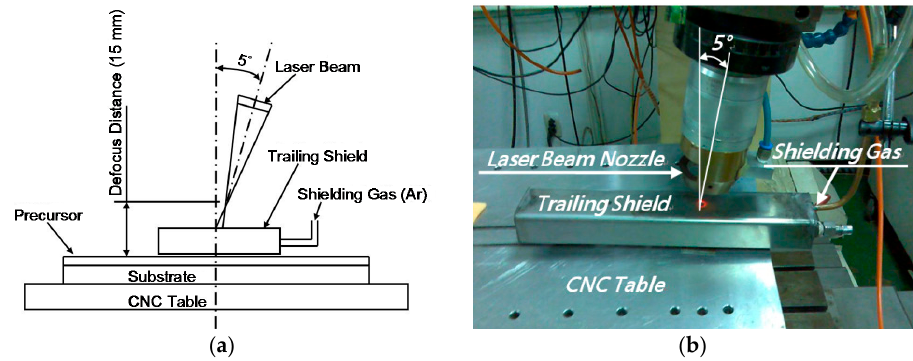
Figure 3. ( a ) Schematic illustration of Nd-YAG laser cladding system which was controlled by the computer numerical control (CNC); and ( b ) photograph of experimental setup.